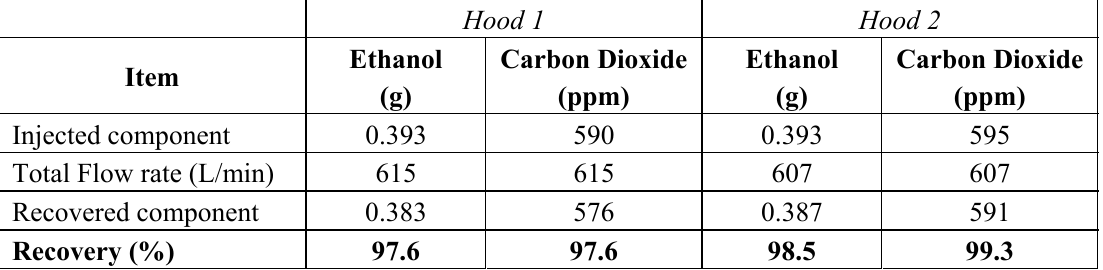
Table 2. Injected, recovered gases and calculated recovery